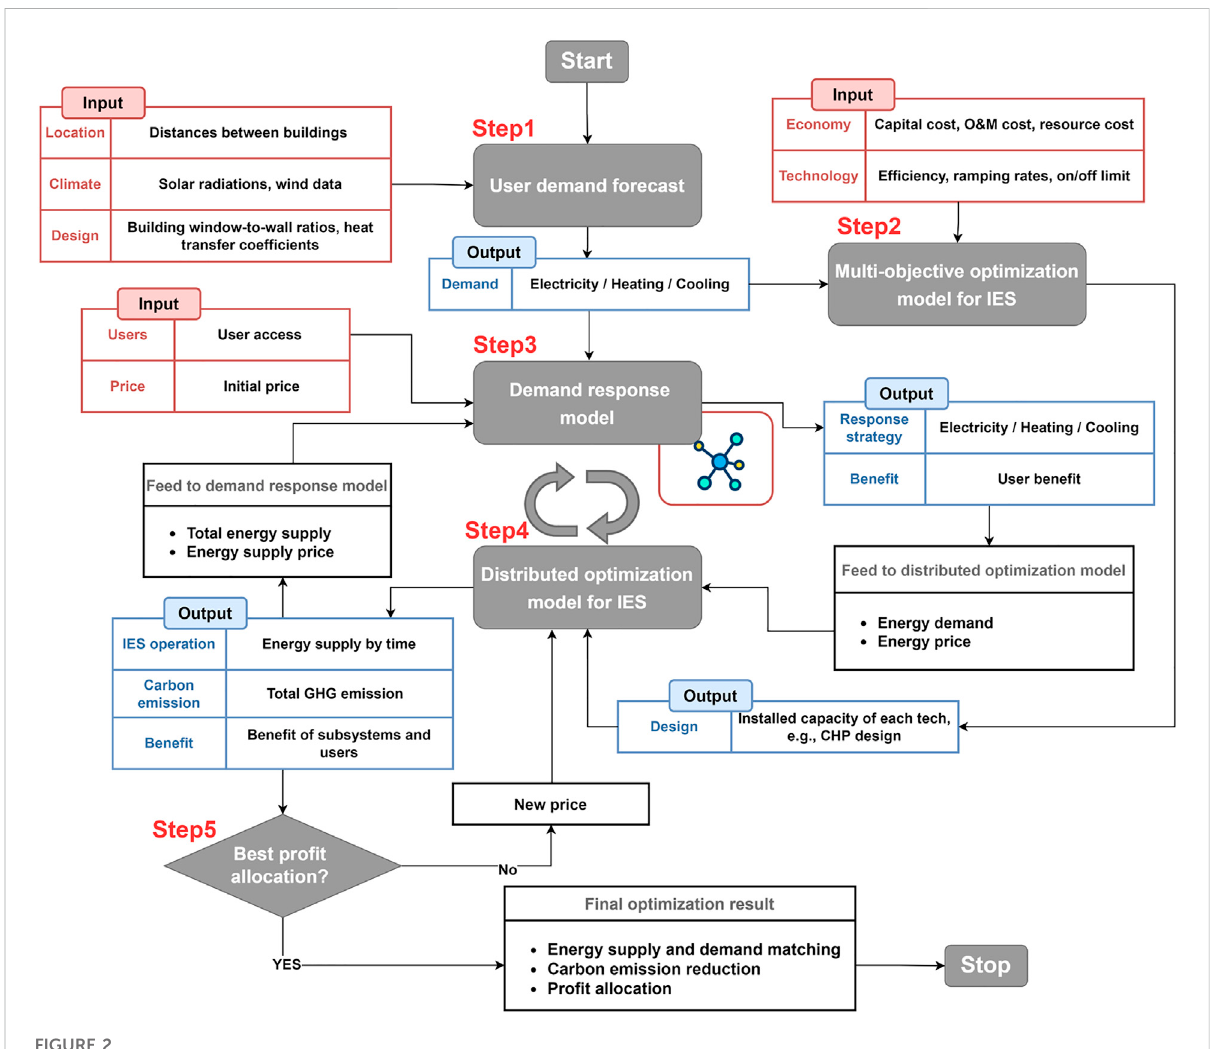
FIGURE 2 The process diagram of the proposed